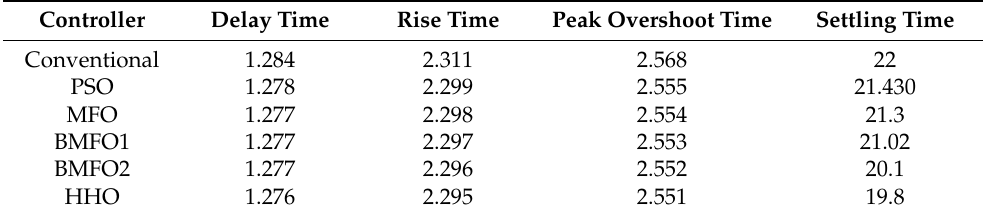
Table 18. Graph analysis of deviation in tie-line error with various controllers under contract violation